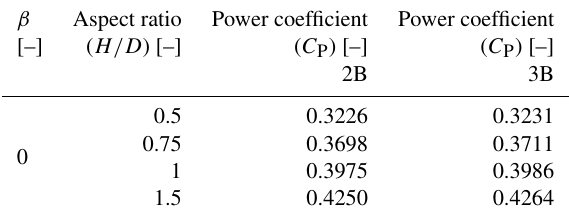
Table 4. Maximum power coefficient ( C P ) for different aspect ratio (AR)